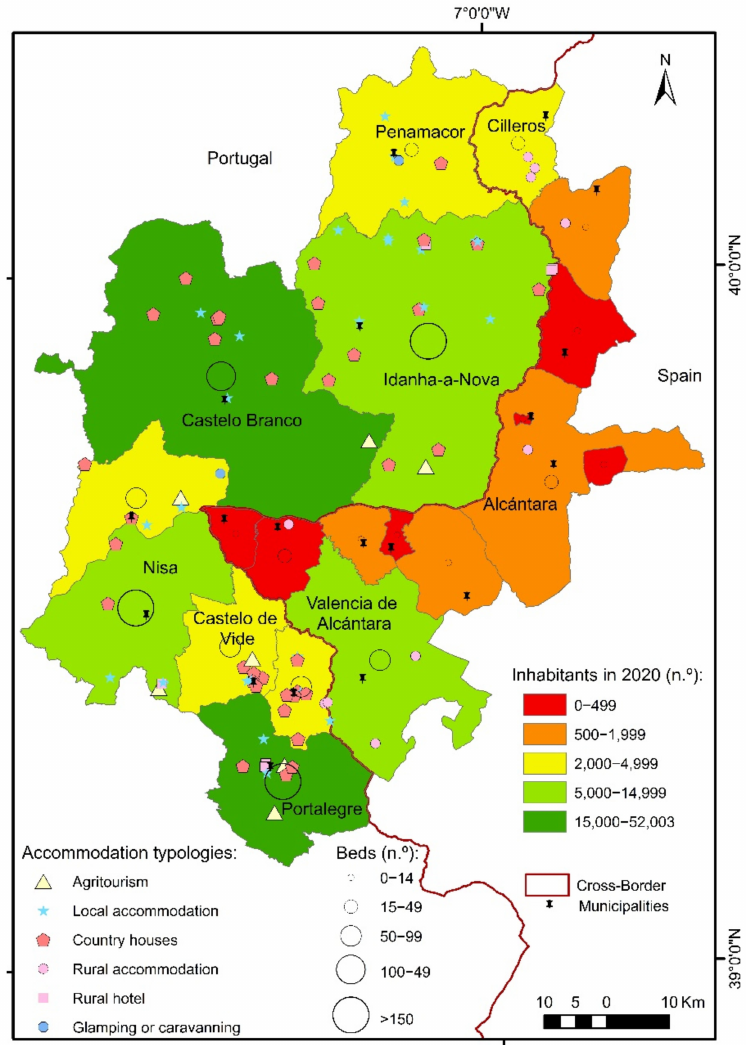
Figure 1. Inhabitants in study area (2020) and accommodation distribution by typology and number of